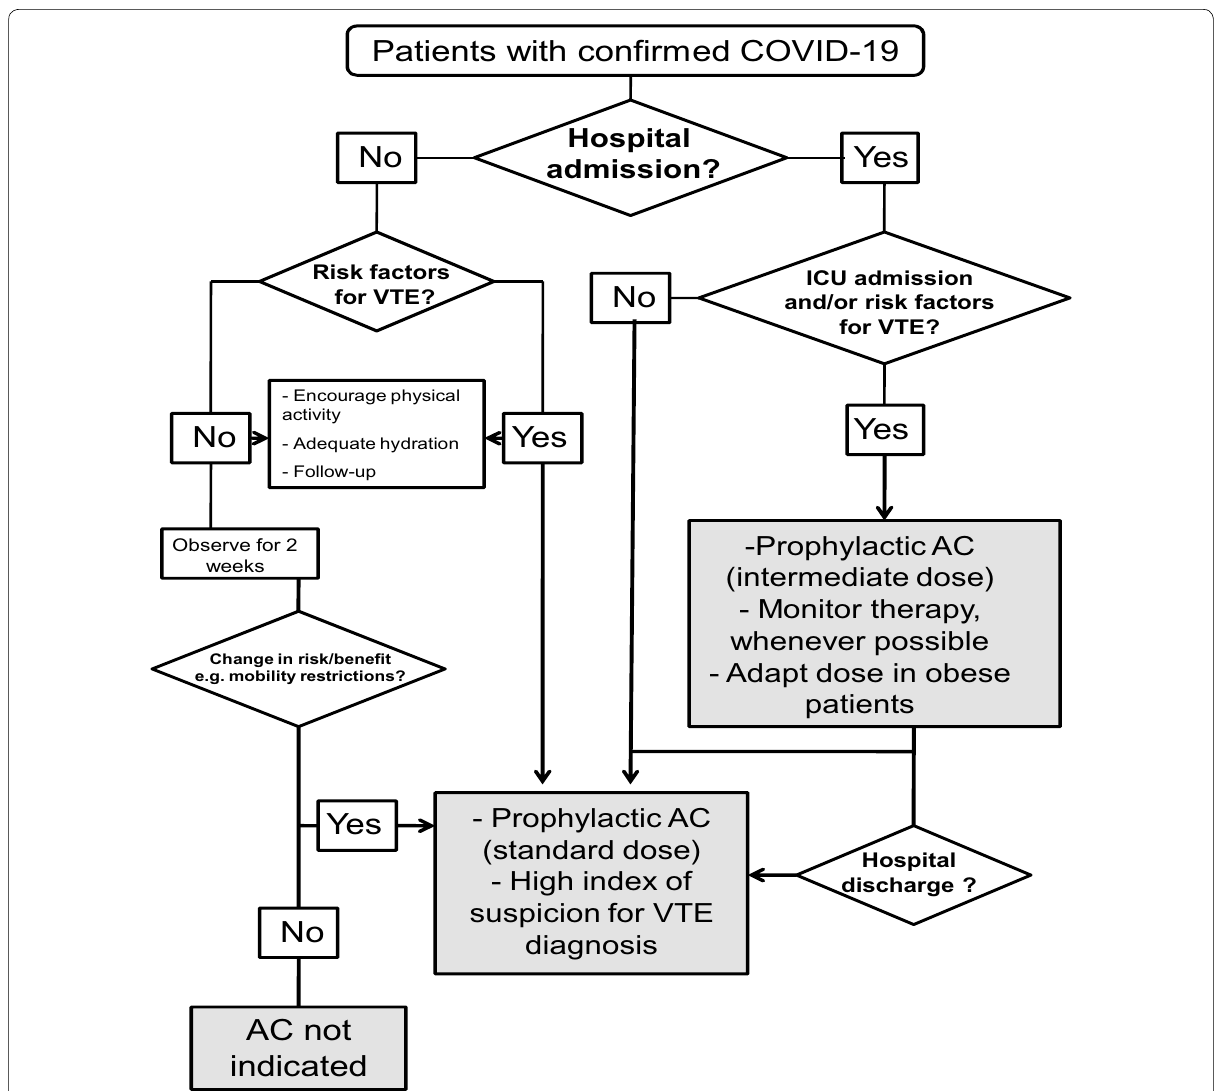
Fig. 2 Flow diagram of the recommended procedure for initiating thromboprophylaxis in patients with coronavirus disease-2019 (COVID-19). The choice of the appropriate method for anticoagulation (AC) should be based on individual risk/benefit assessment (see text for details). COVID-10: coronavirus disease-2019, VTE: venous